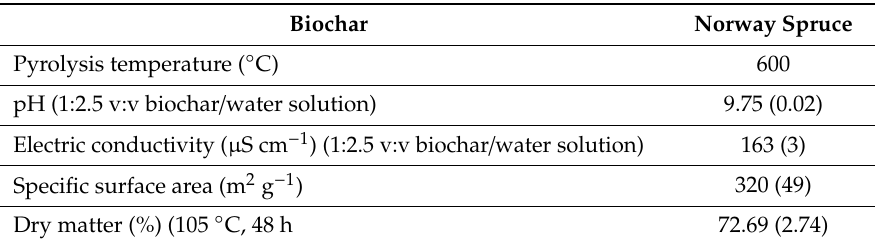
Table 1. Characteristics of the biochar used in the study.